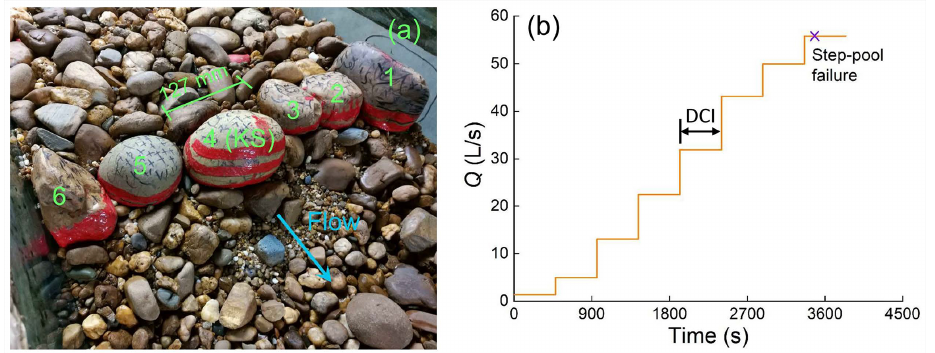
Figure 2. Flume experiment settings in Zhang et al. (2020): (a) the artificially built-up step-pool model using natural stones with stone number labeled and (b) the unsteady hydrograph of the run used in this study. KS in (a) is short for keystone, and DCI in (b) is discharge change interval. The run index in (b) is CIFR (continually increasing flow rate) T2.